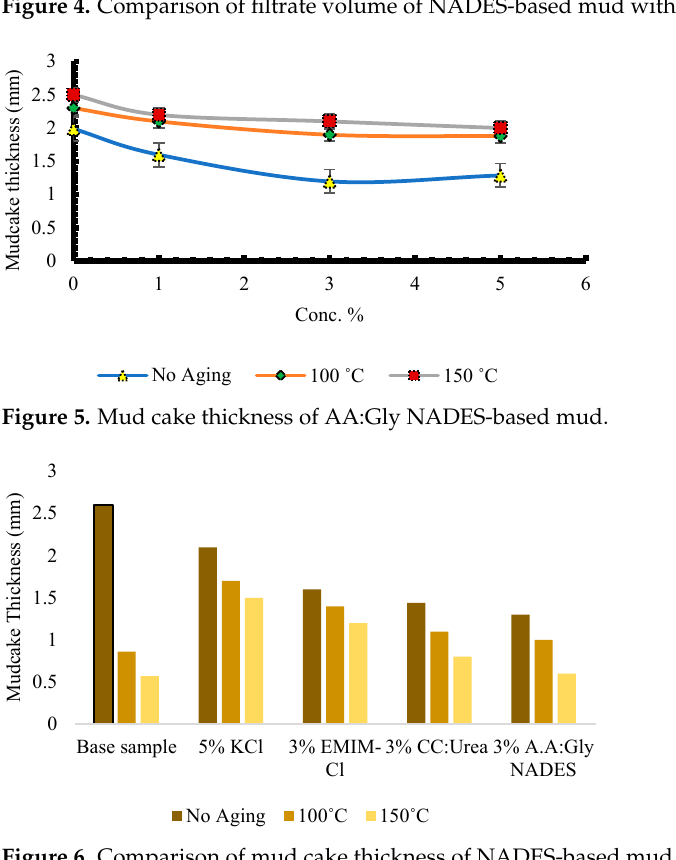
Figure 6. Comparison of mud cake thickness of NADES-based mud with other inhibitors.